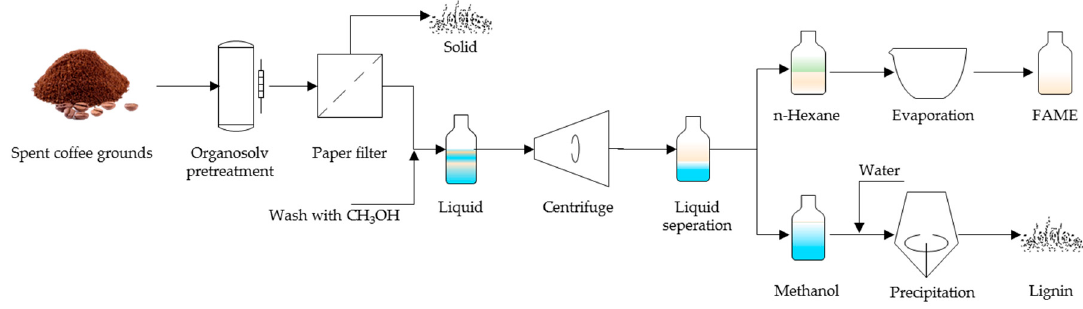
Figure 1. A schematic diagram of sequential separation procedure.